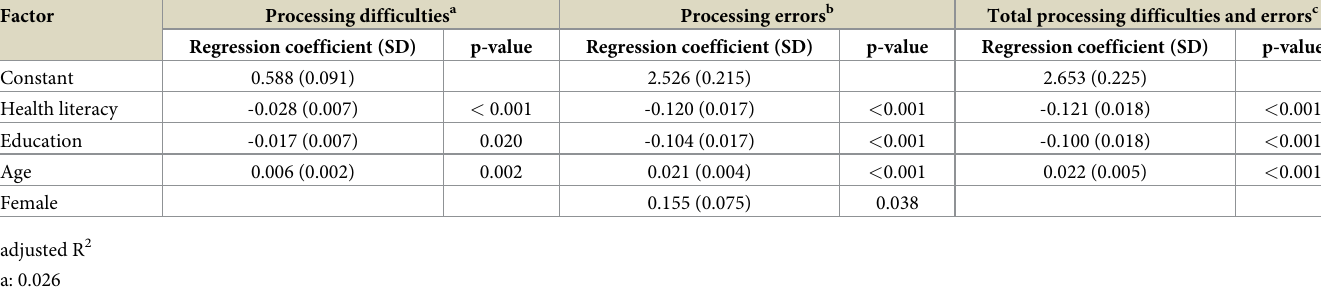
Table 5. Multivariate linear regression models for demographic factors related with processing difficulties and errors